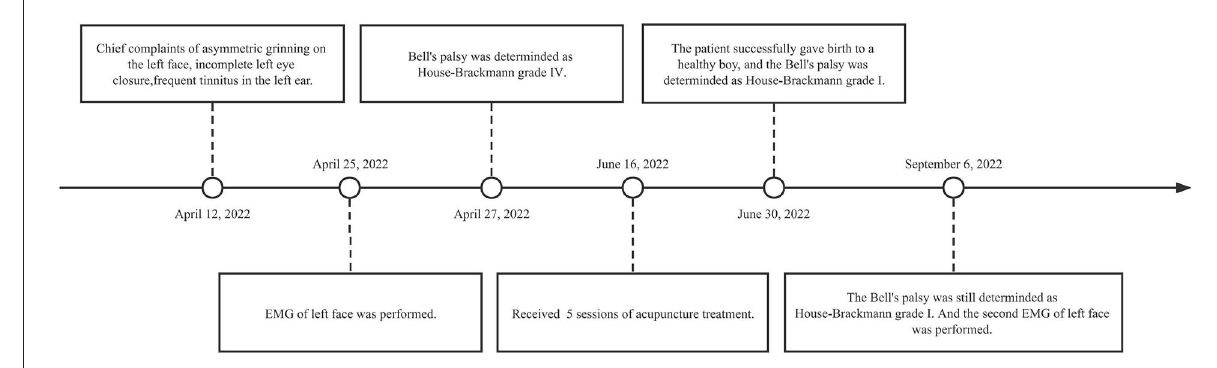
FIGURE1 Timeline with relevant data from the episode of care.